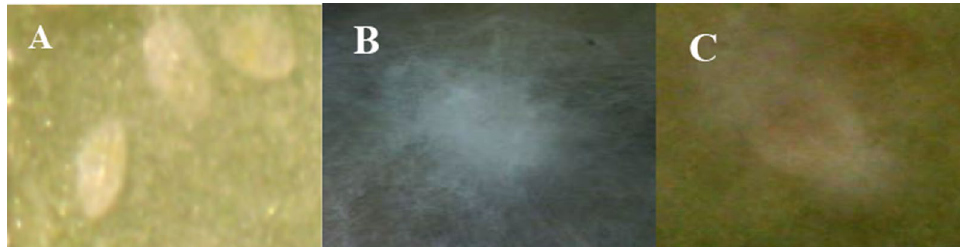
Fig. 6 The infection of Bemisia tabaci second instar nymphs treated with Isaria javanica and Purpureocillium lilacinum observed under a stereomicroscope A Healthy whitefly nymph before application B B. tabaci nymph after 8 days of infection by I. javanica ; C: B. tabaci nymph after 8 days of infection by P. lilacinum